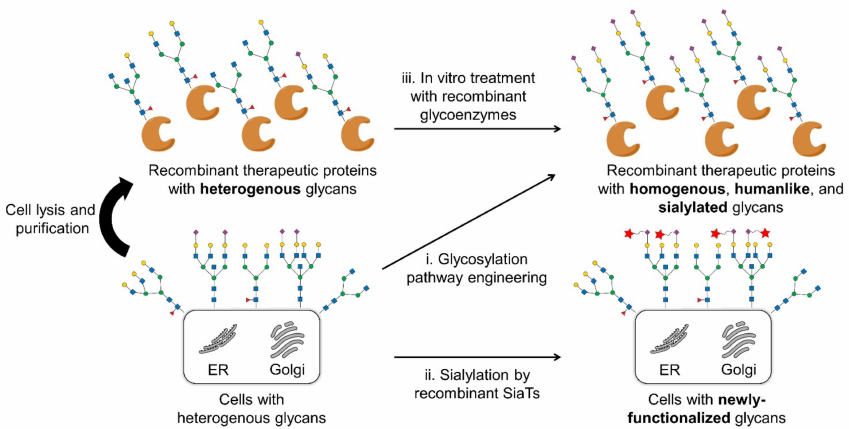
Figure 1. Strategies to achieve humanlike glycosylation through pathway engineering and in vitro sialylation. (i) Sialylation with Neu5Ac via pathway engineering or using recombinant SiaTs can reduce immunogenicity and increase the serum stability of recombinant proteins. Purified glycoen- zymes, including SiaTs, may be used (ii) to functionalize cell-surface glycans, e.g., with a fluorescent dye and reaction handles, such as azido, alkyne, and biotin moieties, or (iii) to modify recombinant proteins to improve homogeneity and humanlike